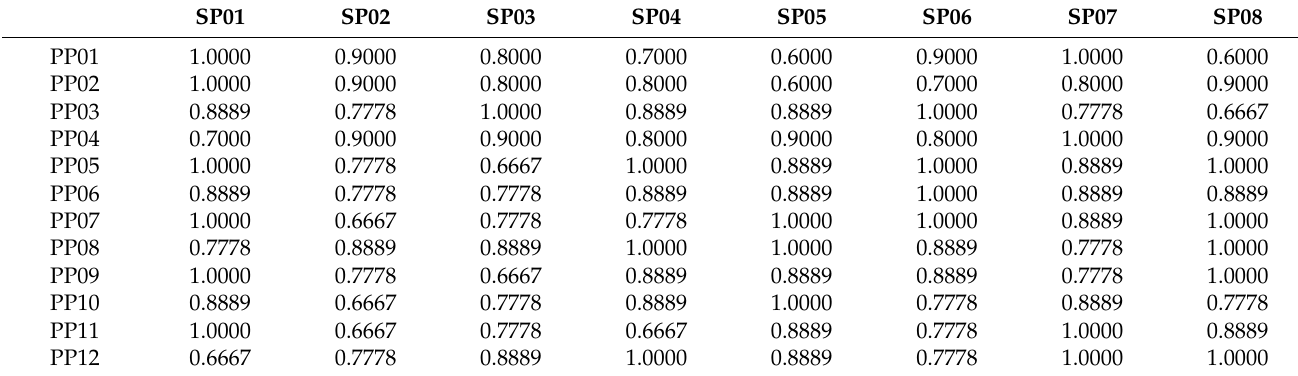
Table 3. Normalized matrix.